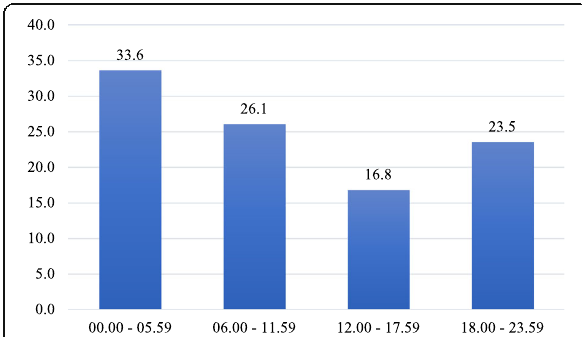
Fig. 6 Percent of time of death of